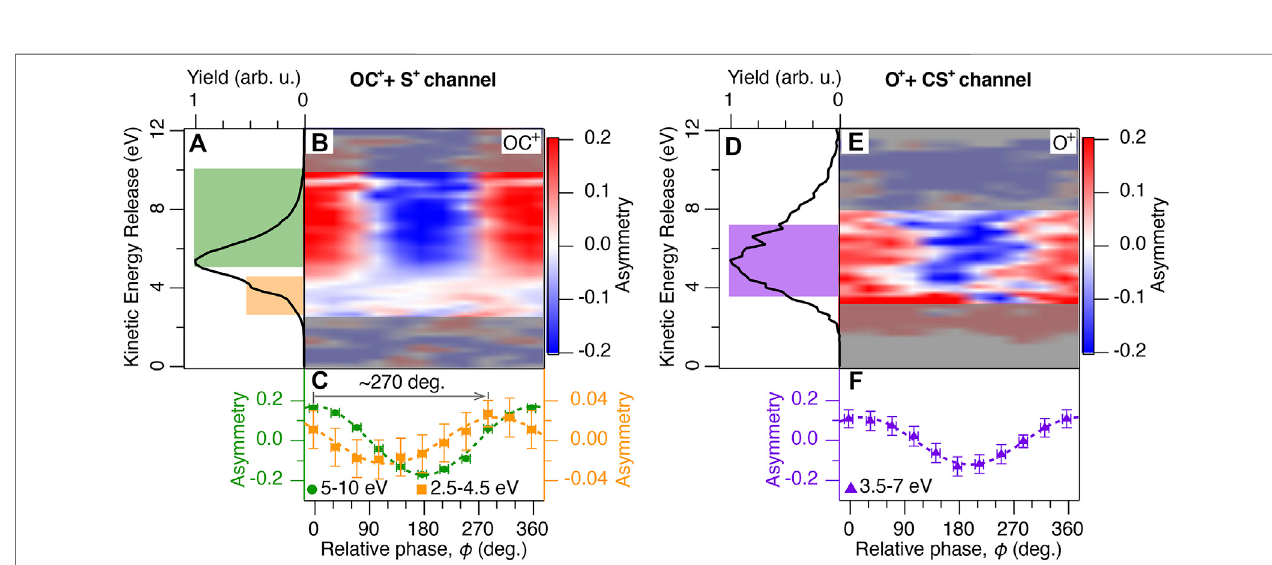
FIGURE 3 | (A) The total kinetic energy release E kin spectrum of the OC + + S + channel averaged over the relative phase ϕ between the ω and 2 ω laser fi elds. The KER spectrum is calculated from the fragments ejected within 45 deg. with respect to the laser polarization direction. The colored areas are linked to the different dissociation pathways indicated in Figure 2 . (B) Two-dimensional plot of the asymmetry parameter as a function of E kin and ϕ . The asymmetry parameter is calculated from the OC + fragment yields. Noisy data outside of the region of interest is masked grey shaded. (C) Asymmetry parameter of the OC + fragments integrated over 5 – 10 eV (green circles) and 2.5 – 4.5 eV (orange squares) are plotted as a function of ϕ . The dotted lines are sine fi ts. (D) Same as (A) , but for the O + + CS + channel. (E) Same as (B) , but calculated from the O + fragment yields. (F) Same as (C) , but the O + fragments are integrated over 3.5 – 7 eV (purple triangles).